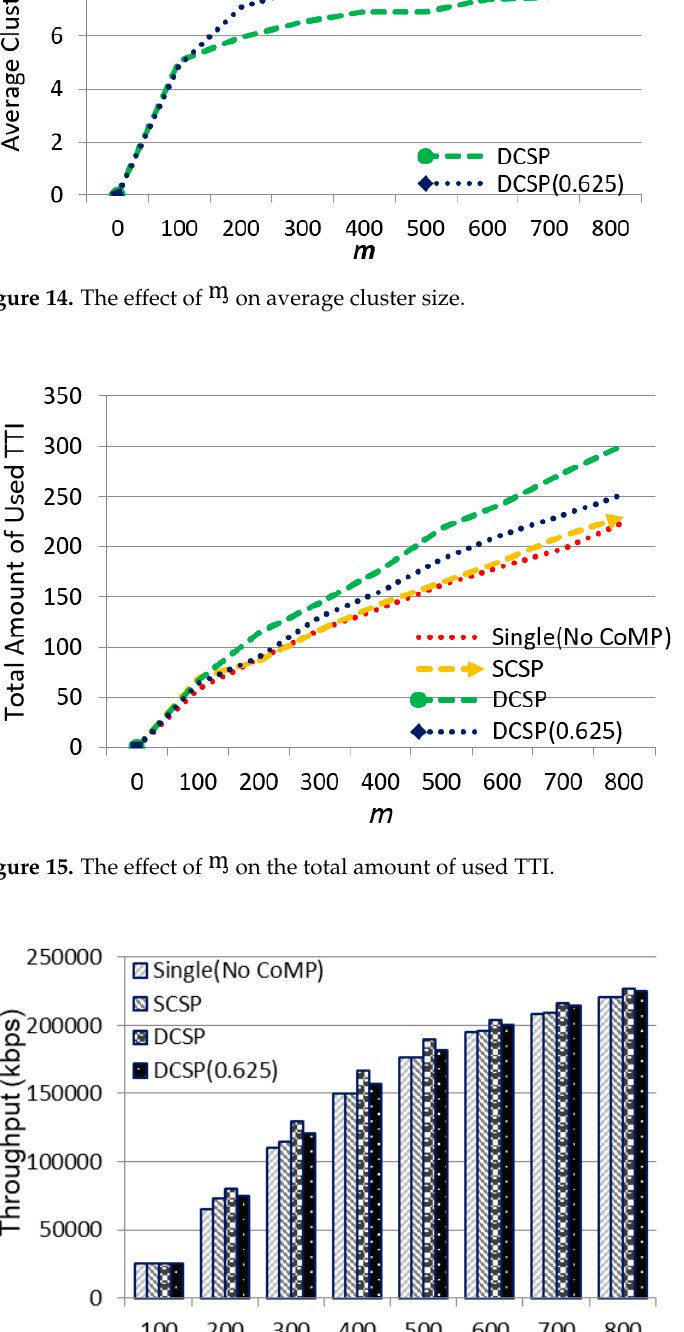
Figure 16. The effect of mean on throughput.